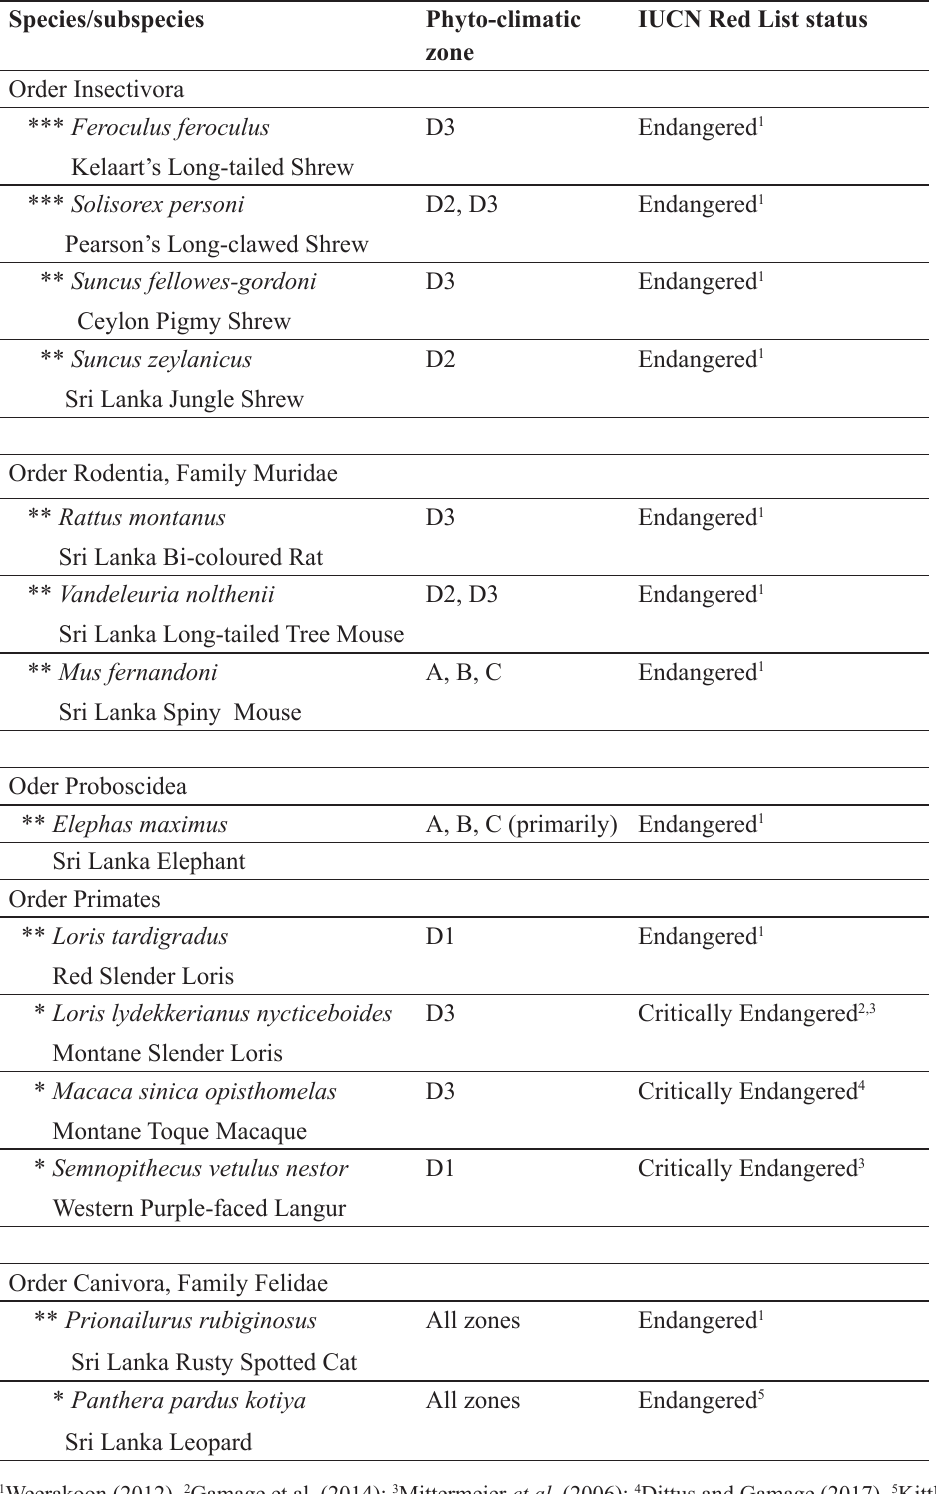
Table 6: The distribution among phyto-climatic zones of Endangered and Critically Endangered endemic mammal taxa (*subspecies, ** species, ***